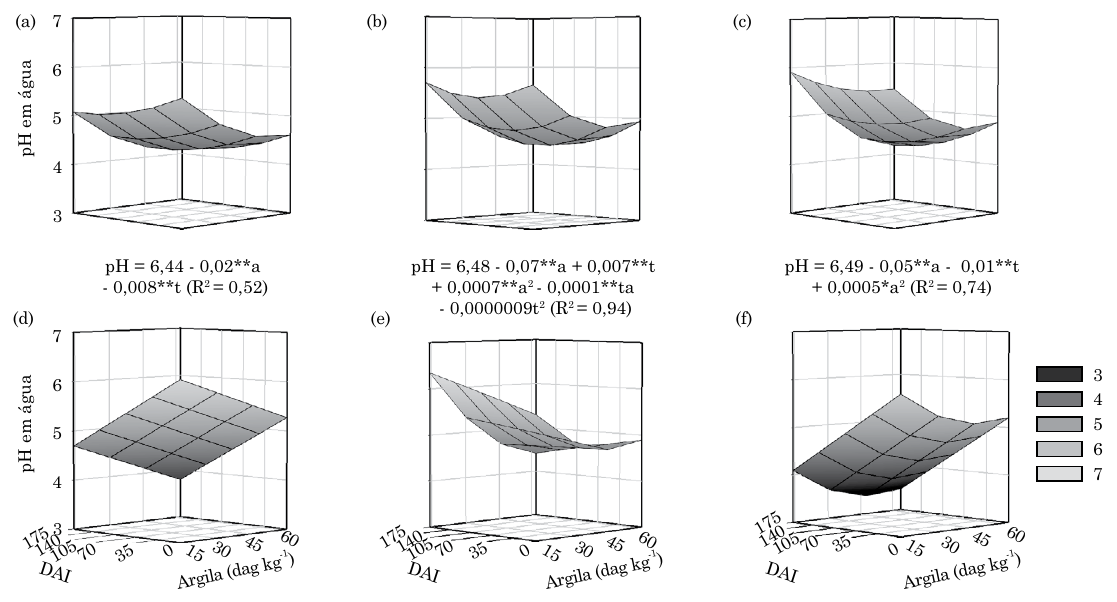
figura 2. pH em água nos solos com fontes inorgânicas dos nutrientes (a), sem adição de nutrientes e resíduo (b); e com resíduo de: milho (c), braquiária (d), feijão (e) e estilosantes (f). * e **: significativos a 5 e 1 %, respectivamente, referentes às variáveis: a – teor de argila, t – tempo e ta - interação entre estes. Dai: dias após o início da